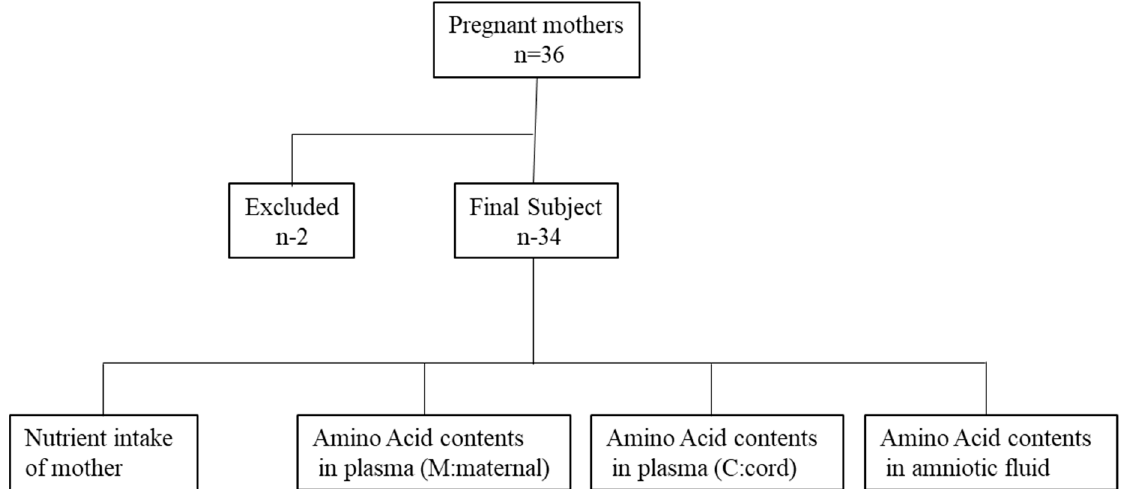
Figure 1. Flow chart of the study.